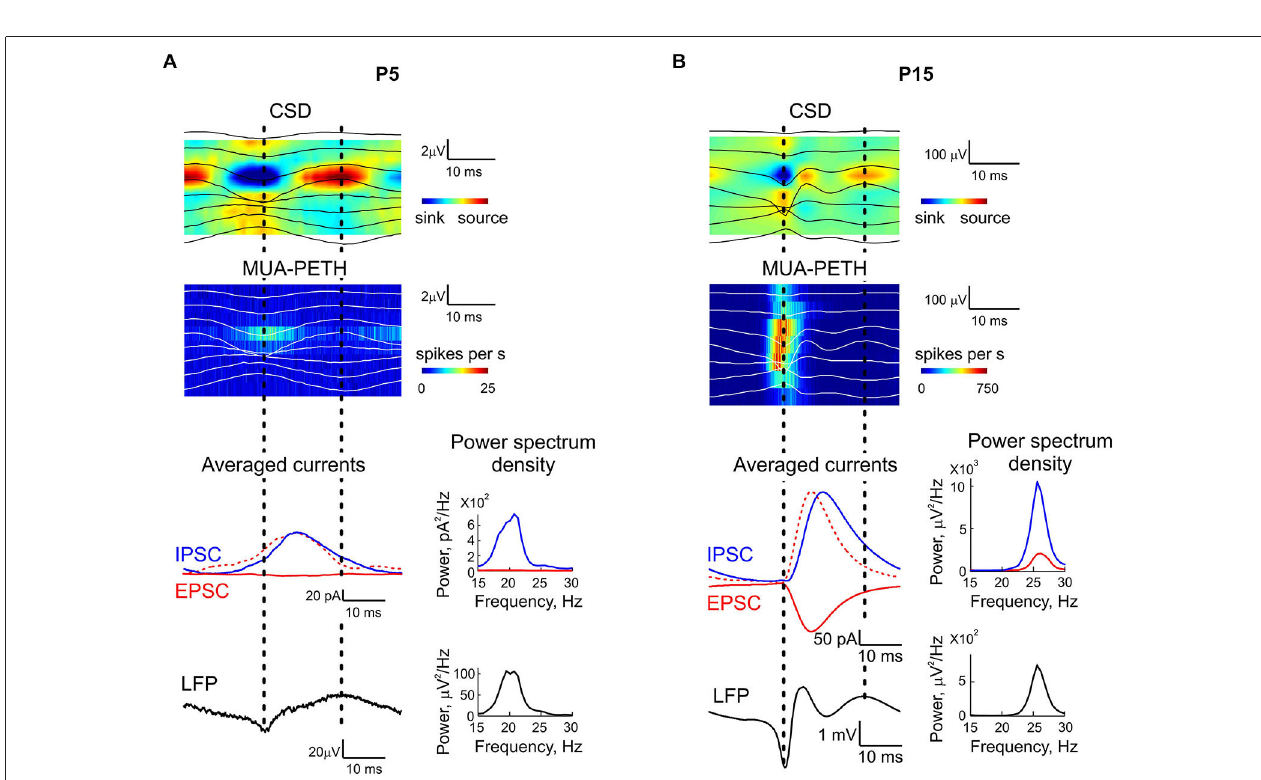
FIGURE 6 | Whole-cell patch-clamp recording of CA3 pyramidal cells during KA-Os . Example traces of spontaneous activity recorded from CA3 pyramidal cells in voltage clamp mode at holding potential 0 mV (blue) and